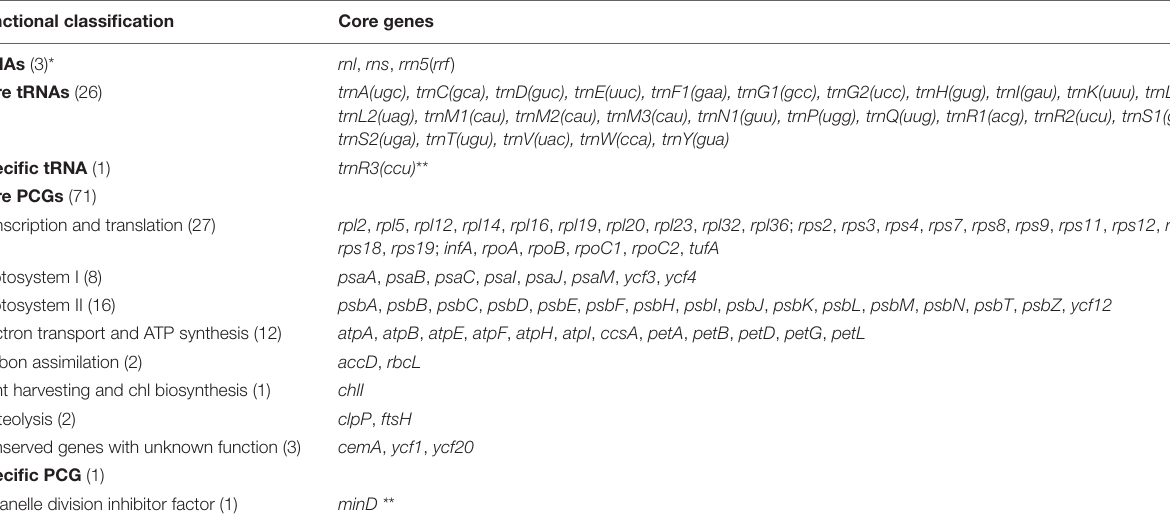
TABLE 2 | Functional classification of 102 genes identified among these 23 Ulva chloroplast genomes. Functional